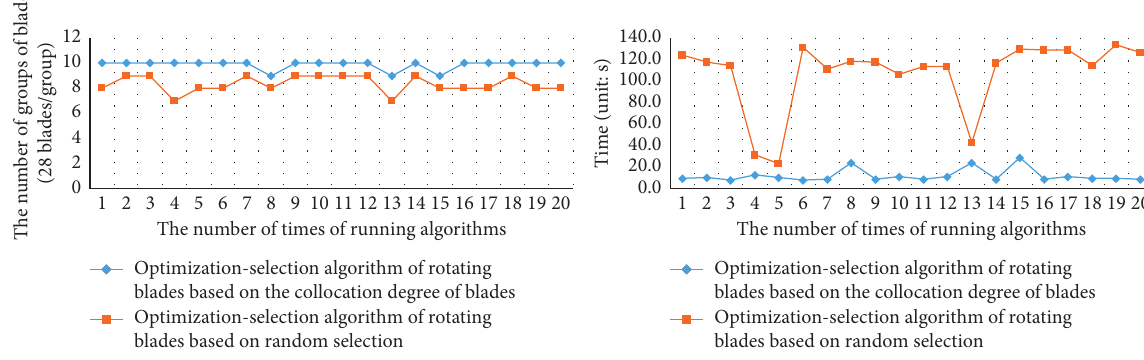
Figure 3: Comparison of the solution effects of the two algorithms based on two